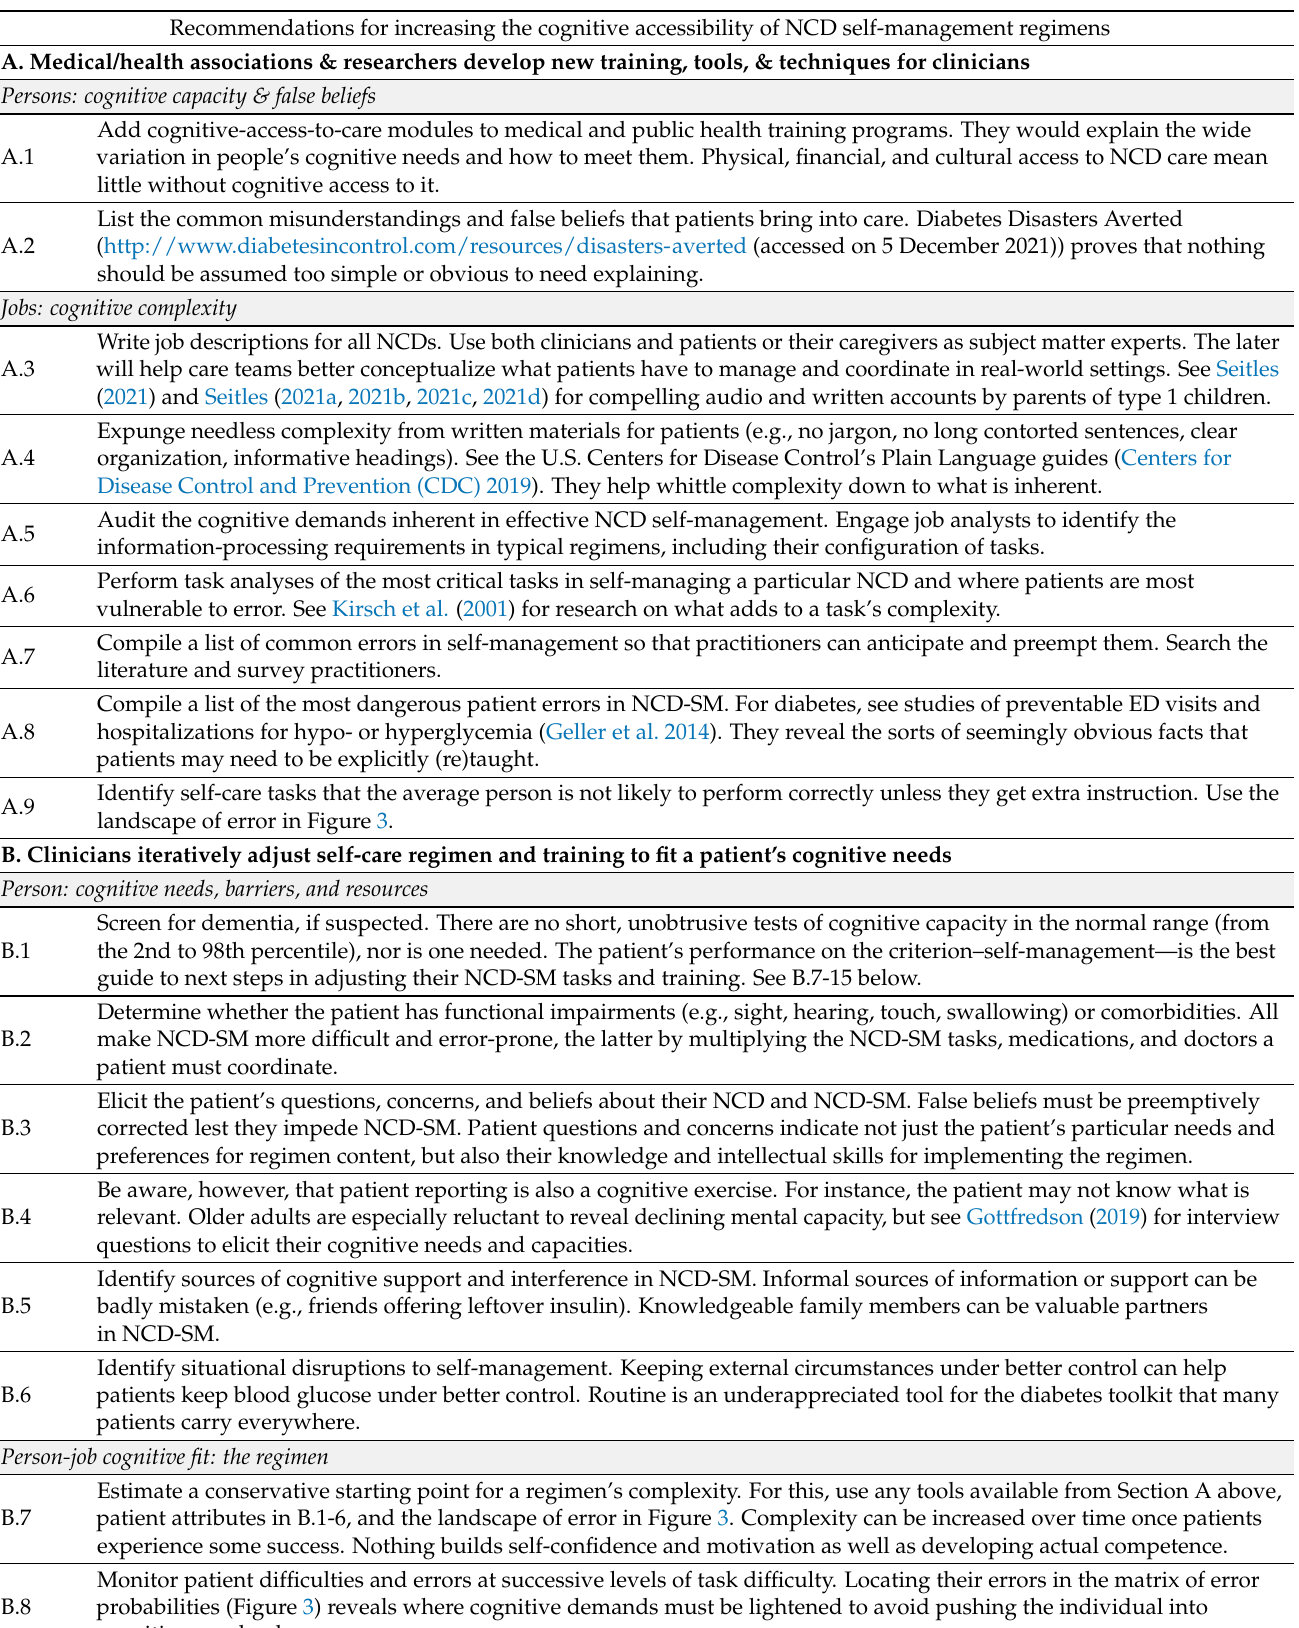
Table 4. Strategies to help clinicians reduce a patient’s cognitive barriers to NCD